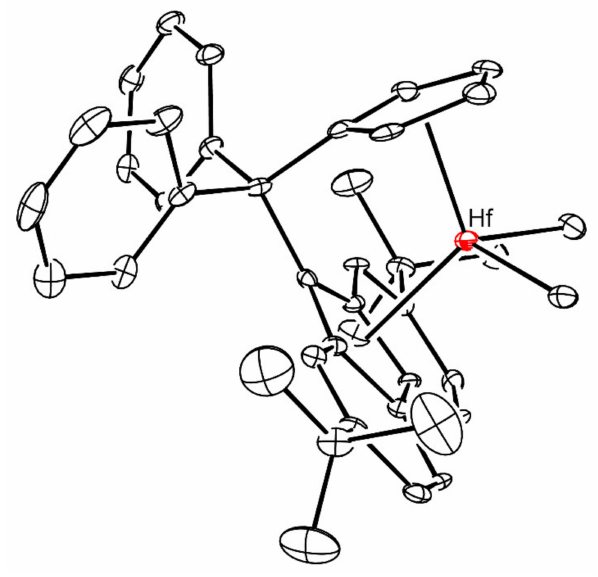
Figure 2. Structure of 4 -HfMe 2 revealed by X-ray